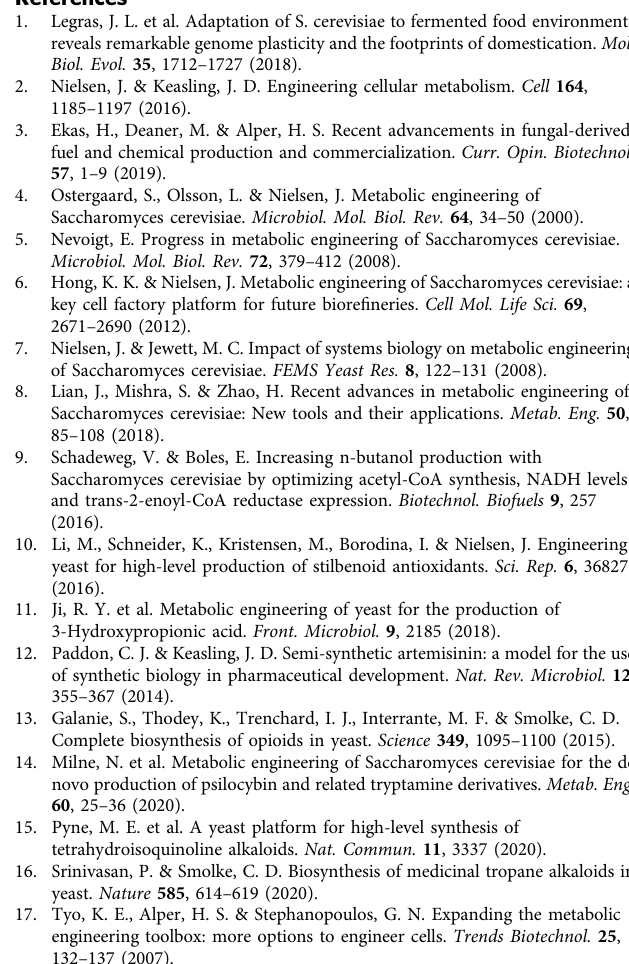
Fig. 3. pH of these reactions was adjusted using glacial acetic acid or potassium hydroxide prior to the addition of yeast extract and cofactors, and initial pH was measured after the addition of all reaction components using an Orion ™ ROSS Ultra ™ Re fi llable pH/ATC Triode ™ (Thermo Scienti fi c). Initial reactions for itaconic acid and glycerol production contained the same concentrations of salts, glucose, buffer, and CoA as the initial BDO reactions. However, NAD and ATP were increased to 3mM to facilitate glucose consumption prior to cofactor optimization, and extract concentration was set at 6 mg/ml. In vivo measurements . Cultures of BDO-producing S. cerevisiae strains were inoculated into 25 mL of YSC media within 250mL shake fl asks (PYREX) at OD